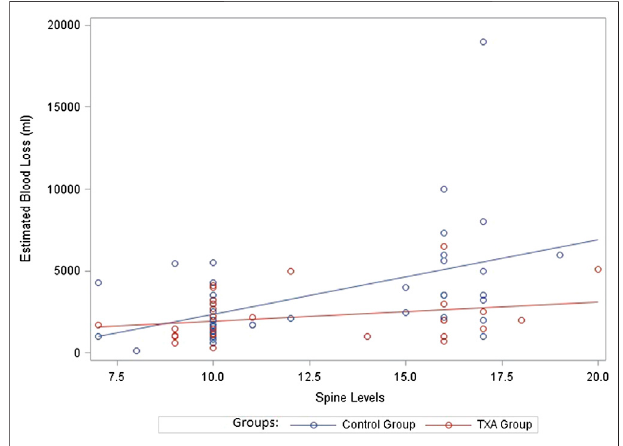
FIGURE 2 | Estimated blood loss. ml, milliliters; TXA, tranexamic